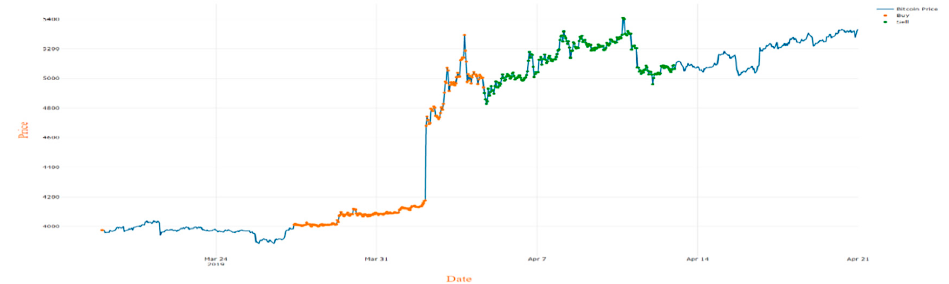
Table 6. Experiment results on Ethereum’s data.